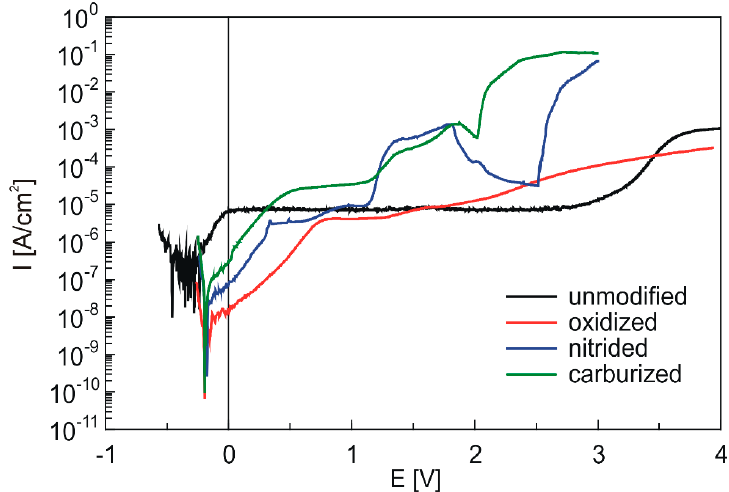
Figure 12. Anodic polarization curves in PBS for the titanium alloy Ti-6Al-4V after different thermo-chemical treatments (scan rate 1 mV/s).